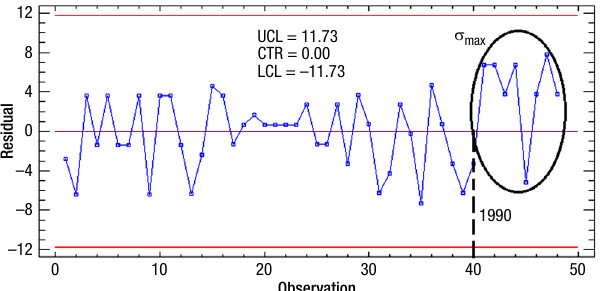
Fig. 19a. ARIMA residual chart for time series of annual Argentinian GDP